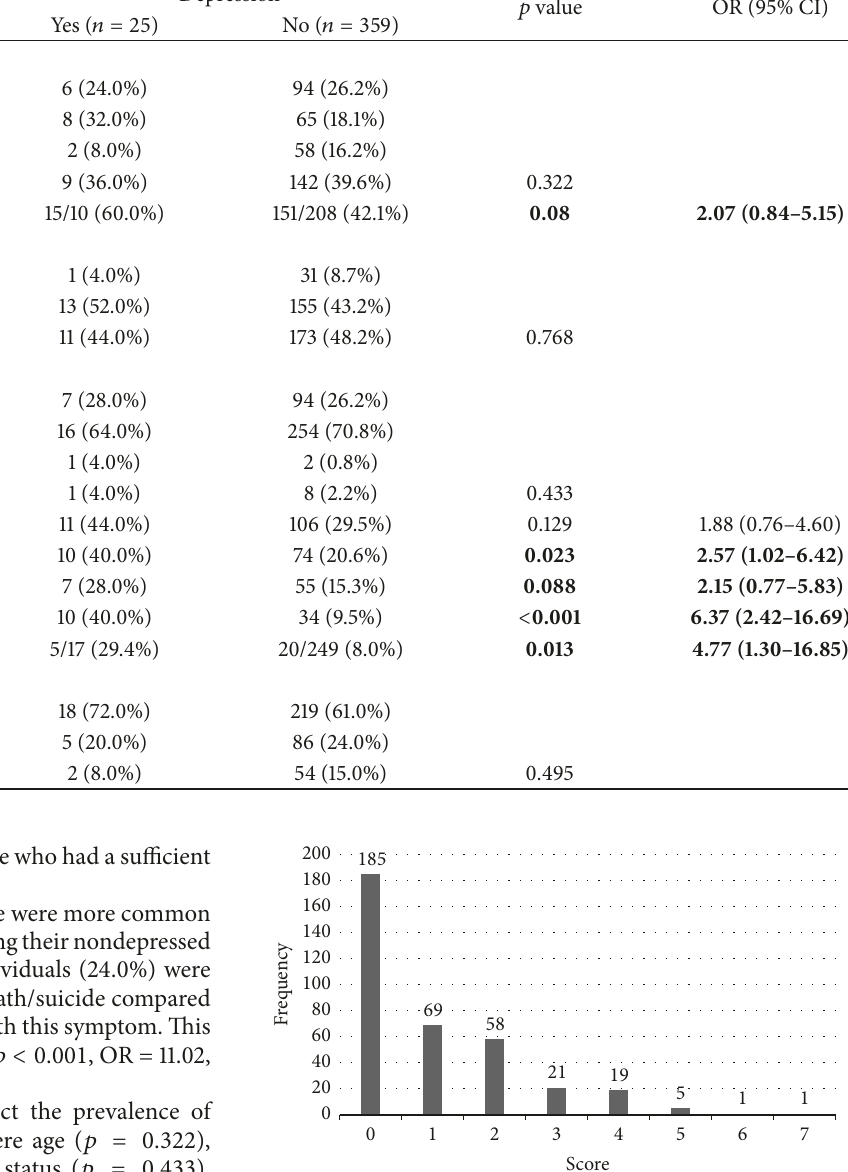
Figure 1: DSM-IV nondepressed individuals by the number of symptoms from DSM-IV depression